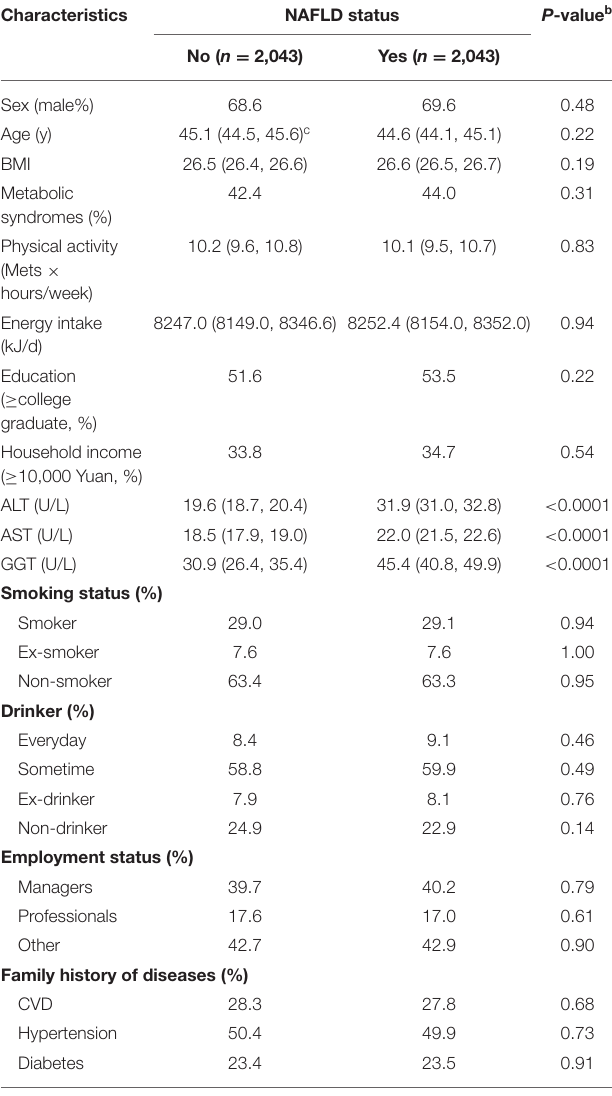
TABLE 1 | Participant characteristics by NAFLD status after matching a